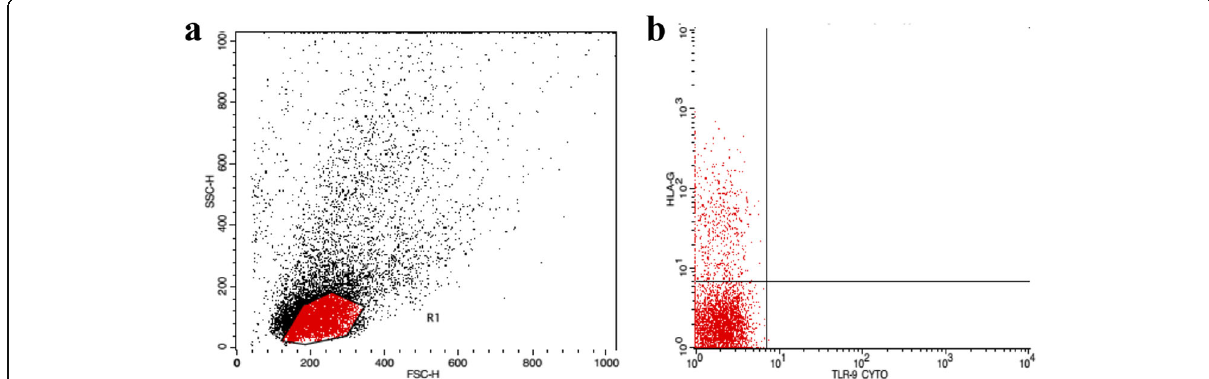
Fig. 1 Flow cytometry of one of the cases. a Gating of lymphocytes. b Expression of